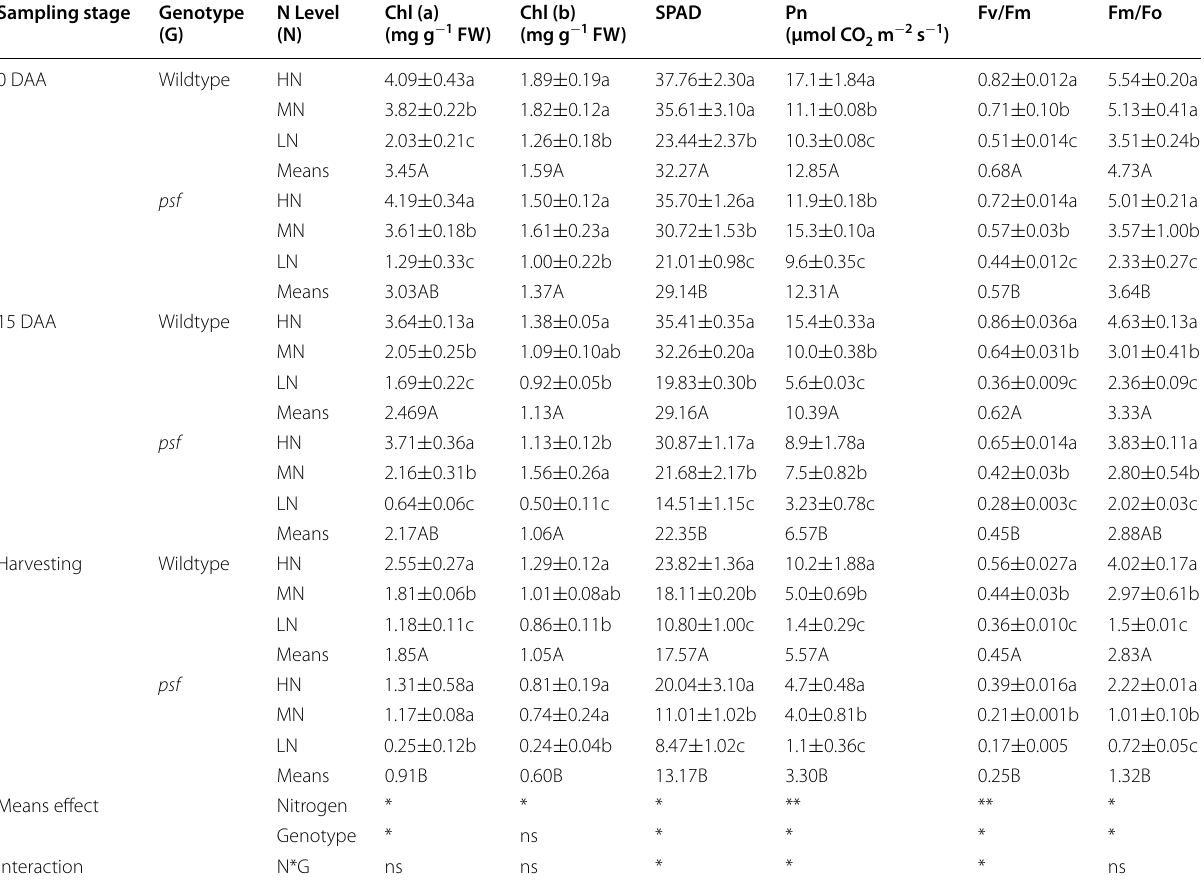
Table 1 Differences in the senescent-associated parameters in the flag leaves of the psf mutant and its wildtype under different N supply